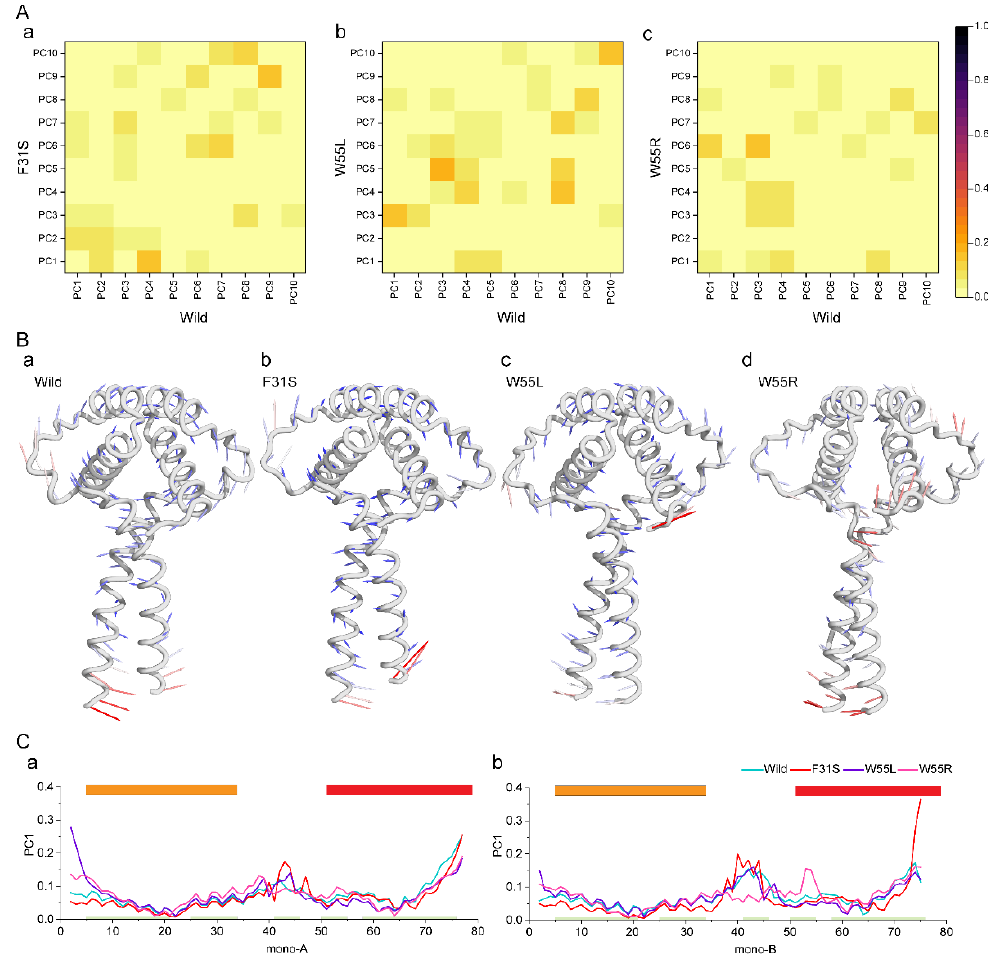
Figure 5. Variations in protein dynamics were revealed by using principal component analysis. ( A ) To demonstrate the similarity and difference among the conformational spaces of wild and variations (F31S ( a ), W55L ( b ), and W55R ( c )) including structures, the root-mean-square inner product (RMSIP) values of the first PC were counted and plotted as a gradient heat map from yellow to dark red to represent low and high values. ( B ) Porcupine plots were used to show the contributing motions in the first PC for wild ( a ), F31S ( b ), W55L ( c ), and W55R ( d ), respectively. ( C ) Line plot showing the degree of mobility captured in PC1 for monomer A ( a ) and B ( b ).